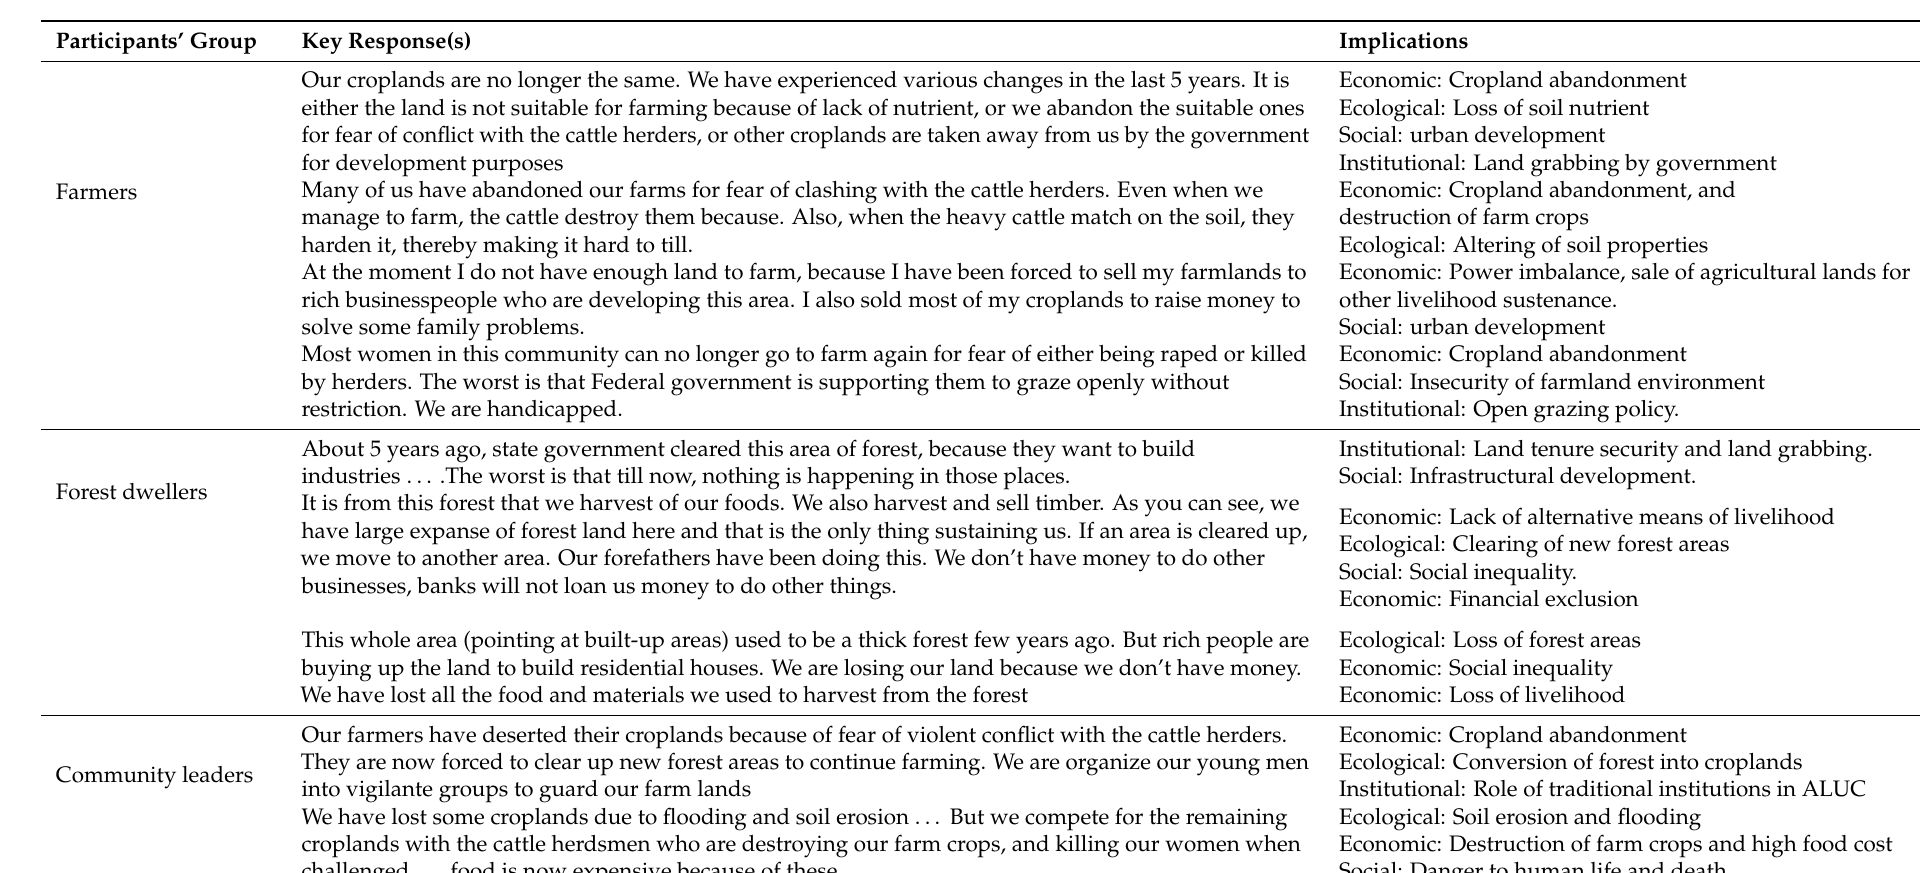
Table 3. Key responses of stakeholders’ perceptions on agricultural land-use change within the last five years in Benue State, Nigeria, and their implications (ecological, economic, social, and